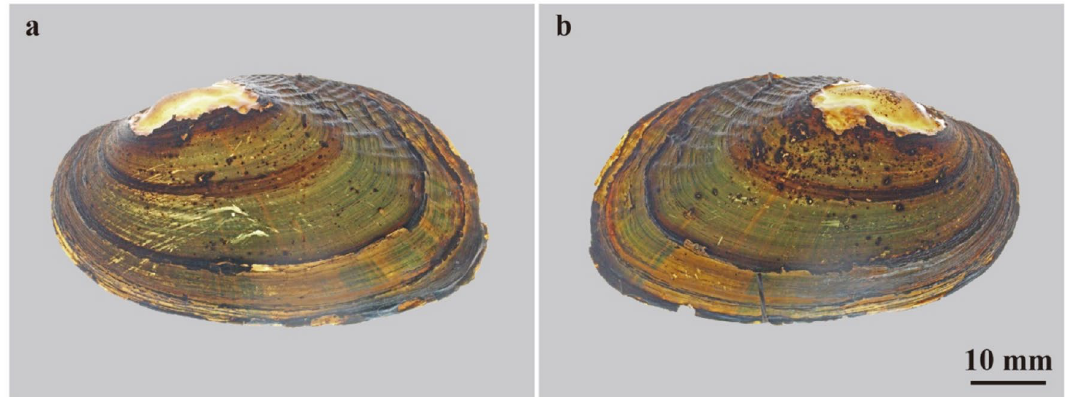
Figure 4. Color patterns of extant freshwater bivalves Obovalis omiensis . ( a,b ) FPDM-I-0002921 from Ise, Mie, central Japan. ( a ) Left valve under transmitted light; ( b ) right valve under transmitted